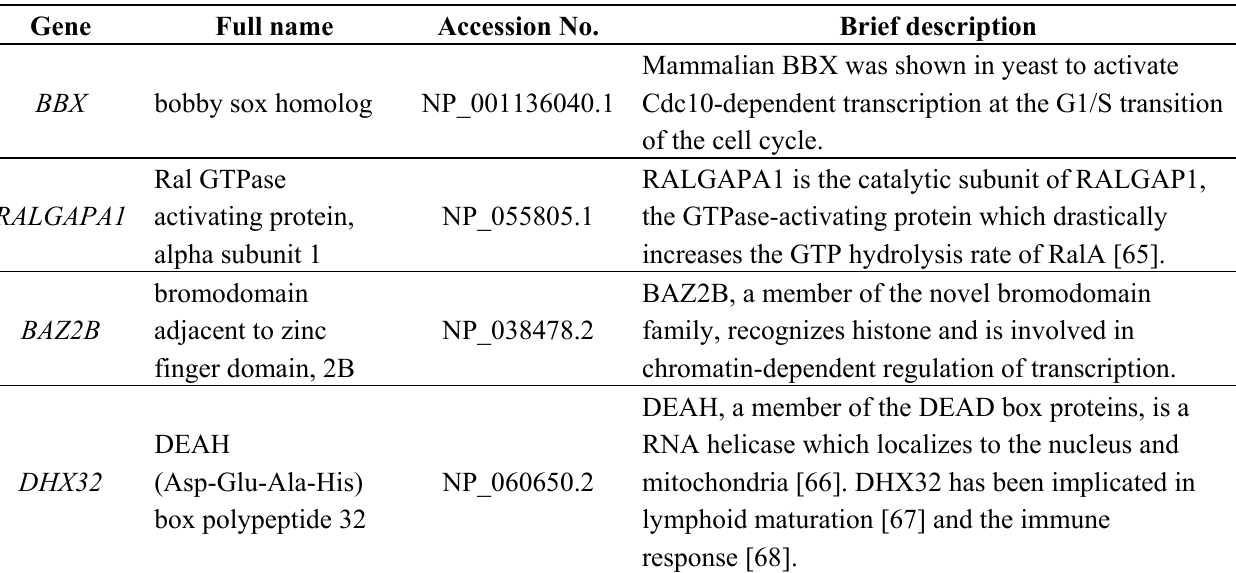
Table 4. Transcription regulation (4